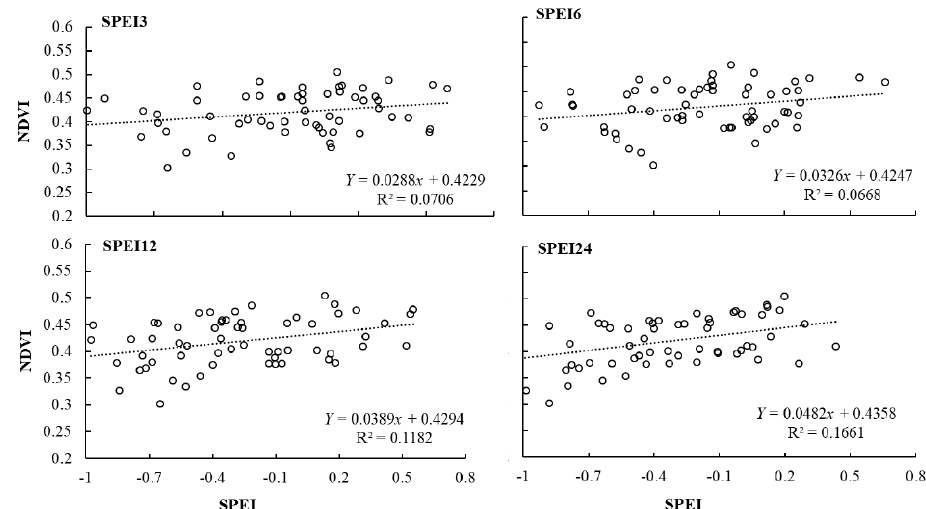
Figure 9. Correlation coefficients between NDVI for the growing season and SPEI at different time scales for 39 meteorological stations.